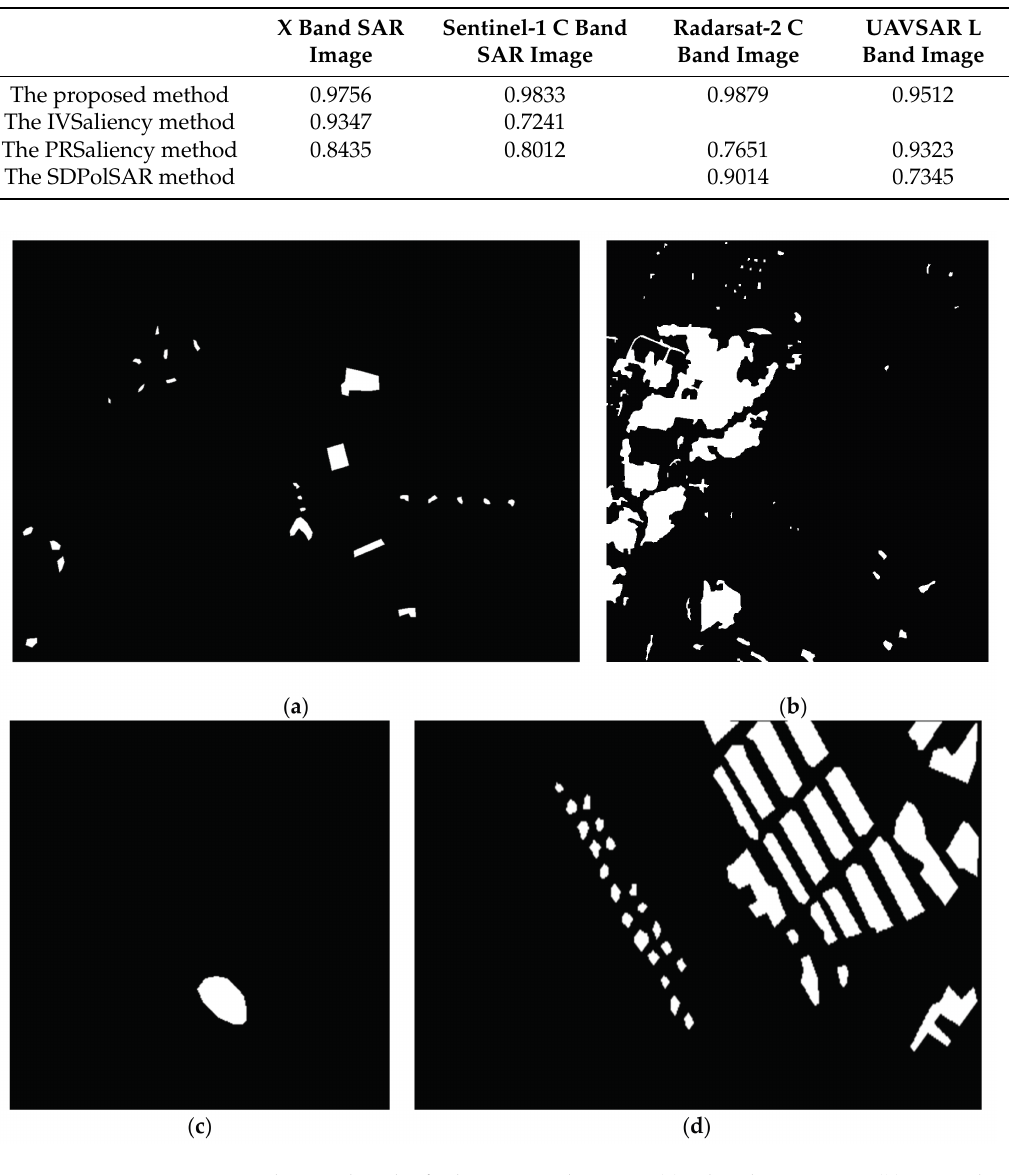
Figure 12. Human-annotated ground truth of salient target detection. ( a ) X-band SAR image; ( b ) Sentinel-1 C-band SAR image; ( c ) Radarsat-2 C-band PolSAR image; ( d ) UAVSAR L-band PolSAR